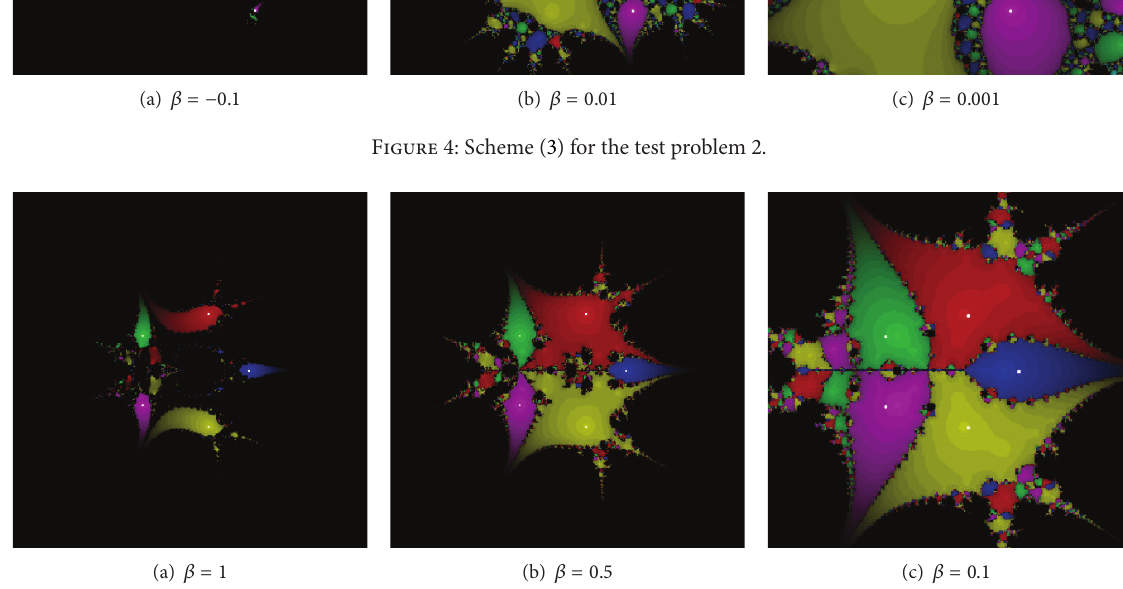
Figure 5: Scheme (3) for the test problem